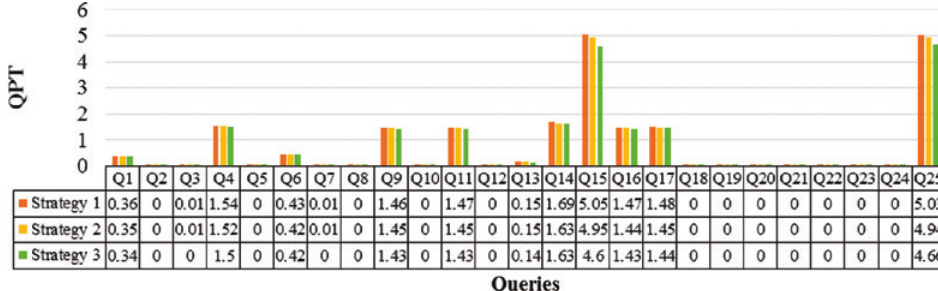
Figure 15: QPT Analysis of Three Strategies on Three Ontologies and A-BOX of Size 20L.